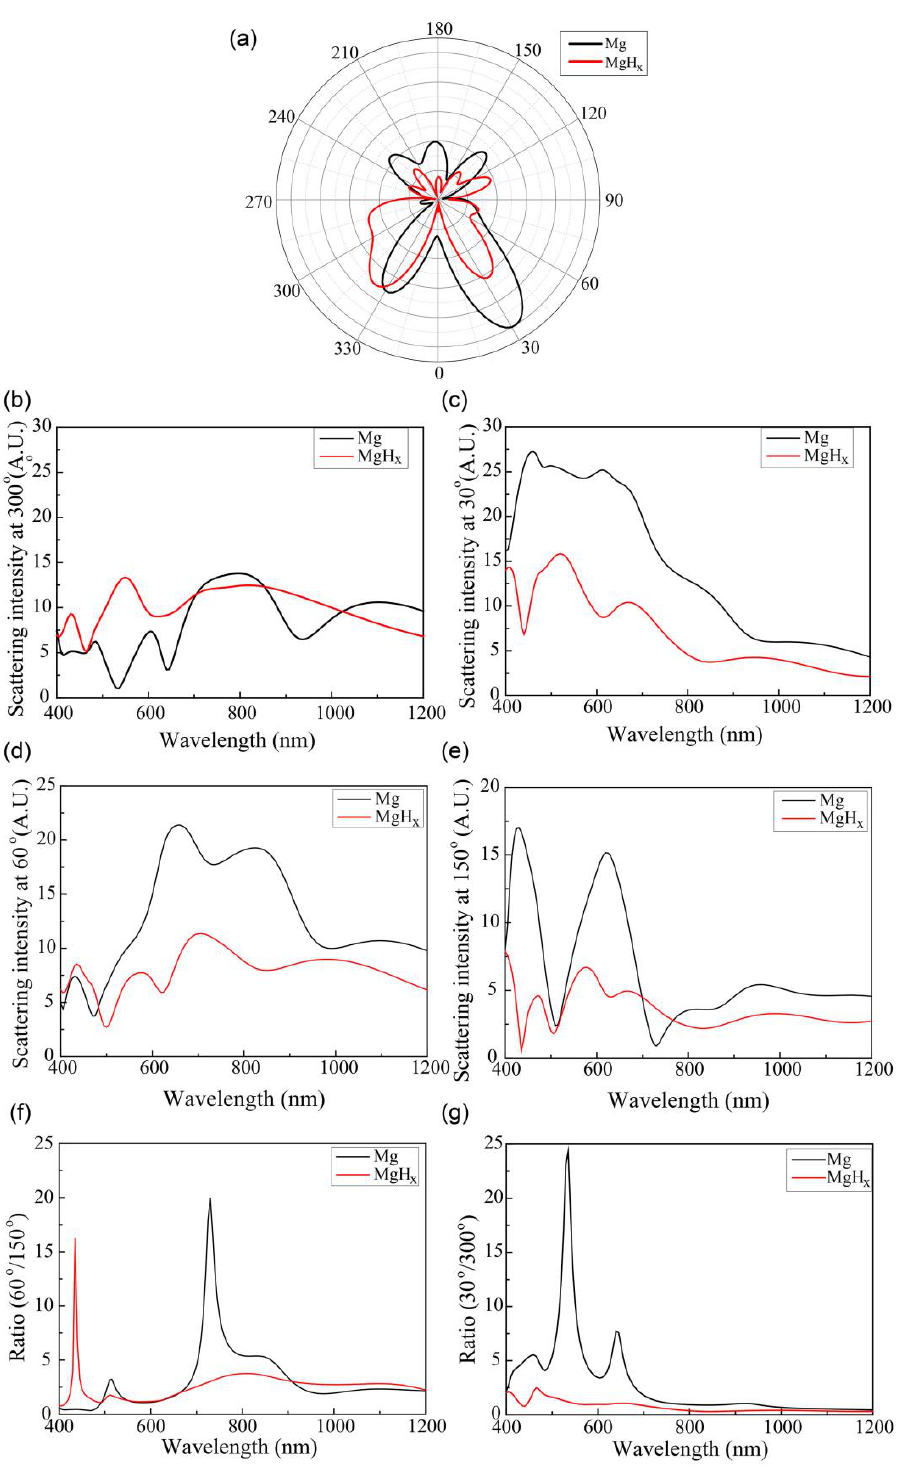
Figure 5. Black and red curves indicate situations before and after hydrogen absorption, respectively. ( a ) Polar graph of far-field scattering of the Ag and Mg nano-blocks for incident light with 535 nm wavelength before and after hydrogen absorption. ( b ) Far-field scattering intensity at 300° for wavelengths of 400 – 1200 nm ( c ) at 30°, ( d ) 60°, ( e ) and 150° before and after hydrogen absorption. ( f ) Far-field scattering intensity ratios of 60° and 150° have maxima at 730 nm (black curve) and 435 nm (red curve). ( g ) The ratio of 30° and 300° reaches a peak at 535 nm (black curve).